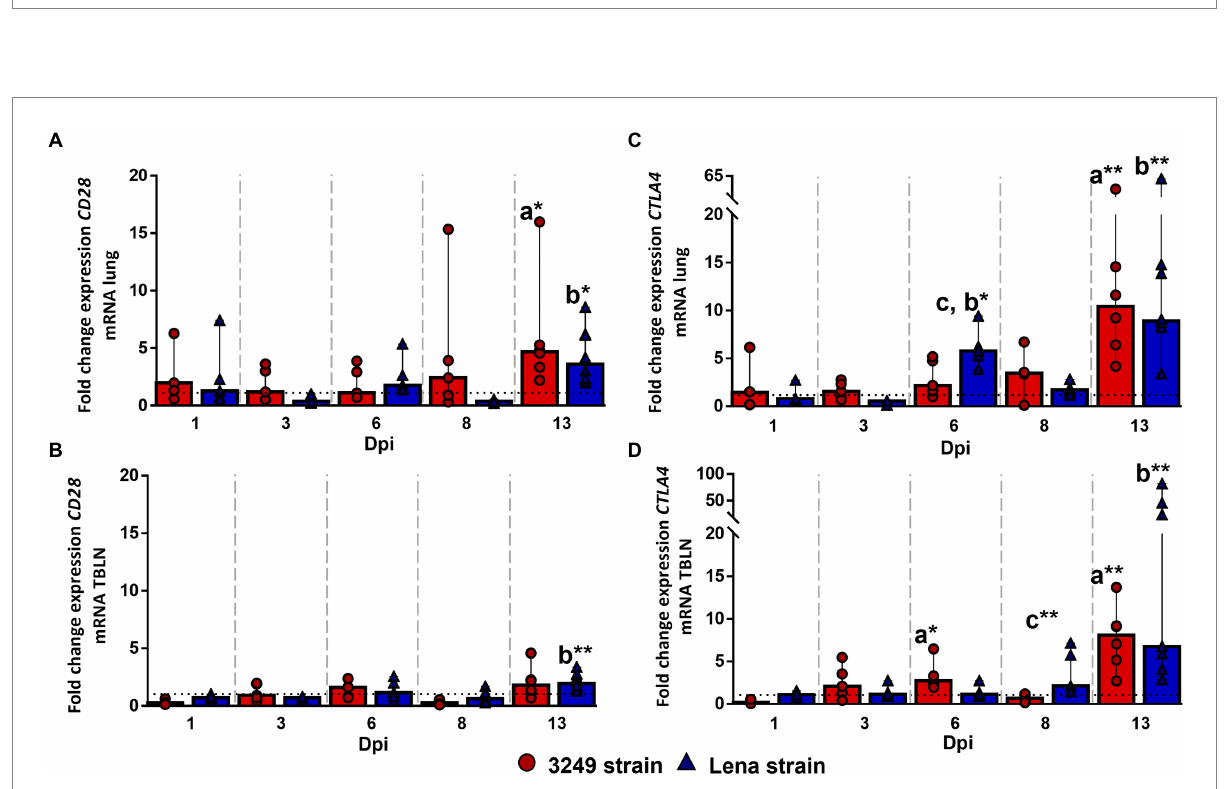
FIGURE 3 Relative mRNA expression of CD28 and CTLA4 mRNA. Graphs show fold change expression of CD28 mRNA in lung (A) and tracheobronchial lymph node (TBLN) (B) , and of CTLA4 mRNA in lung (C) and tracheobronchial lymph node (TBLN) (D) . Columns represent median with interquartile range (IQR). Individual values for each animal from low virulent 3249- (red circles) and virulent Lena- (blue triangles) infected animals are represented. Dashed line shows the expression of CD28 and CTLA mRNA from control group in each organ. “a” indicates a significant difference between the 3249 and control groups, “b” between Lena and control groups and “c” between Lena and 3249 groups (* p ≤ 0.05 and ** p ≤ 0.01). Dpi, days